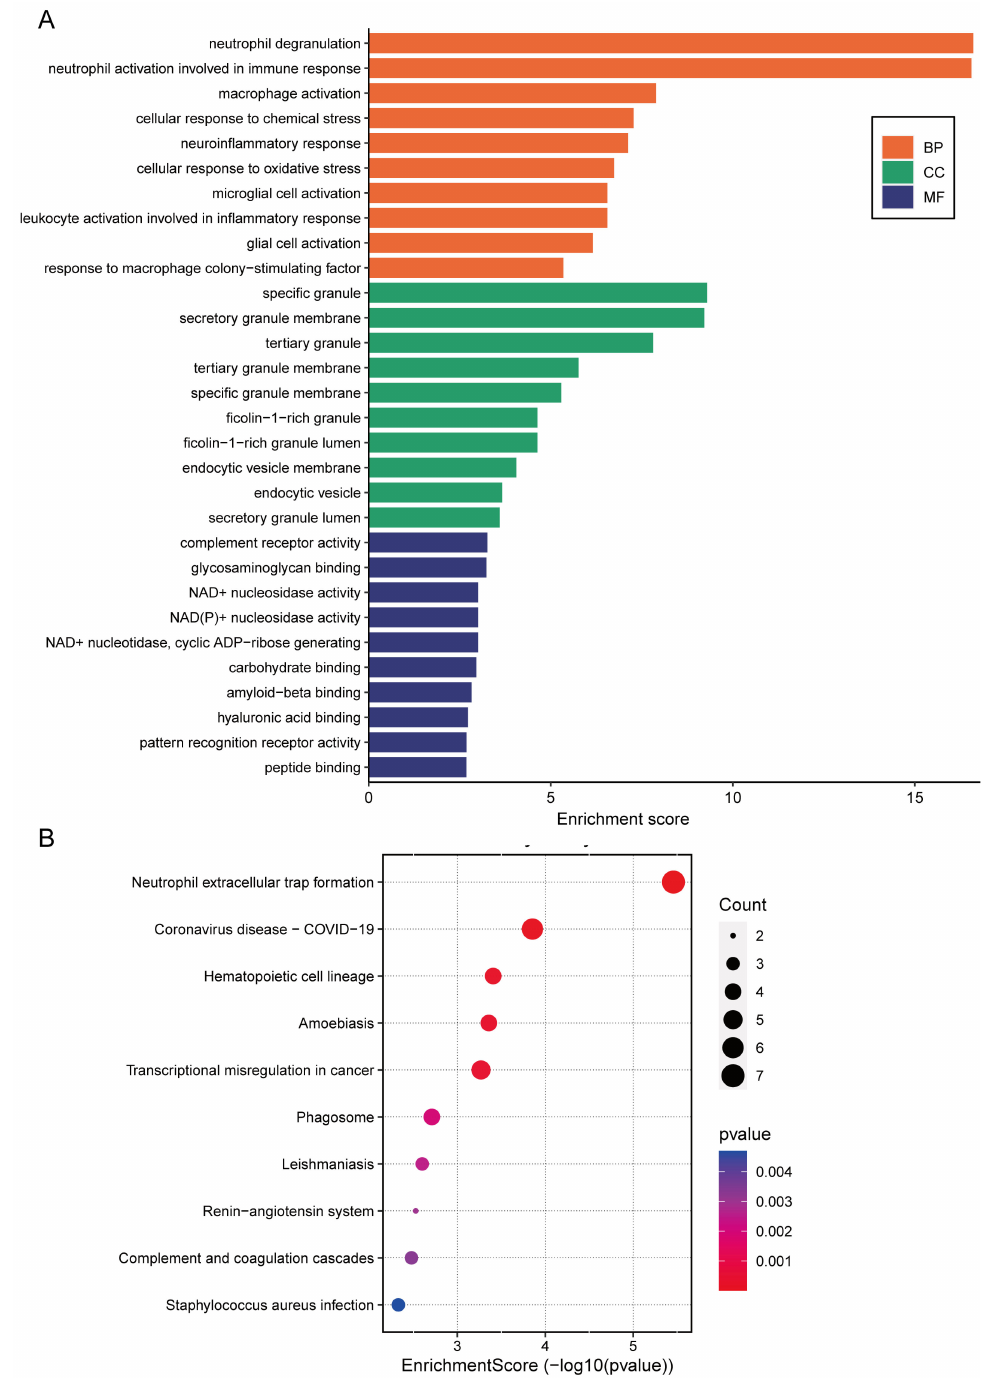
Figure 3. Gene ontology and pathway enrichment analysis. ( A ) GO and ( B ) KEGG enrichment analysis of the 57 common genes identified in CVD and